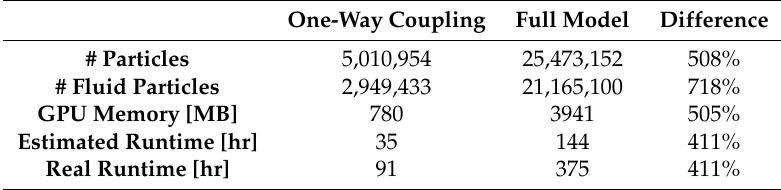
Table 4. Computational speed-up for 3D proof-of-concept.